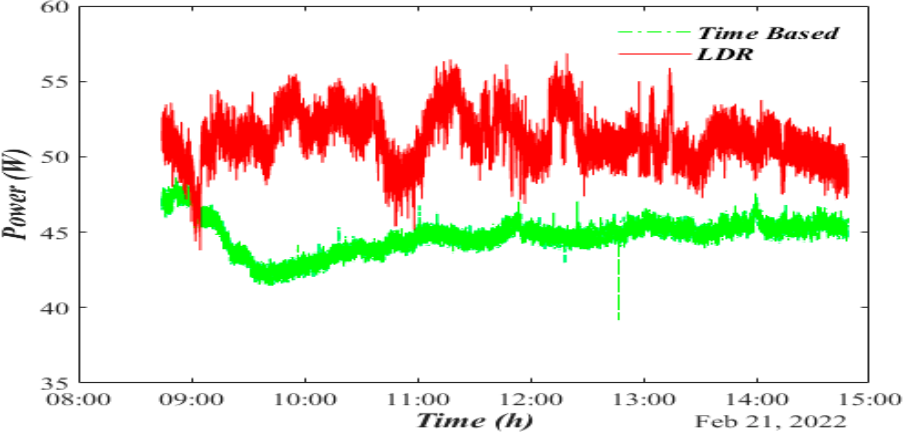
Figure 11. Net power comparison of the azimuth-based system and the sensor-based